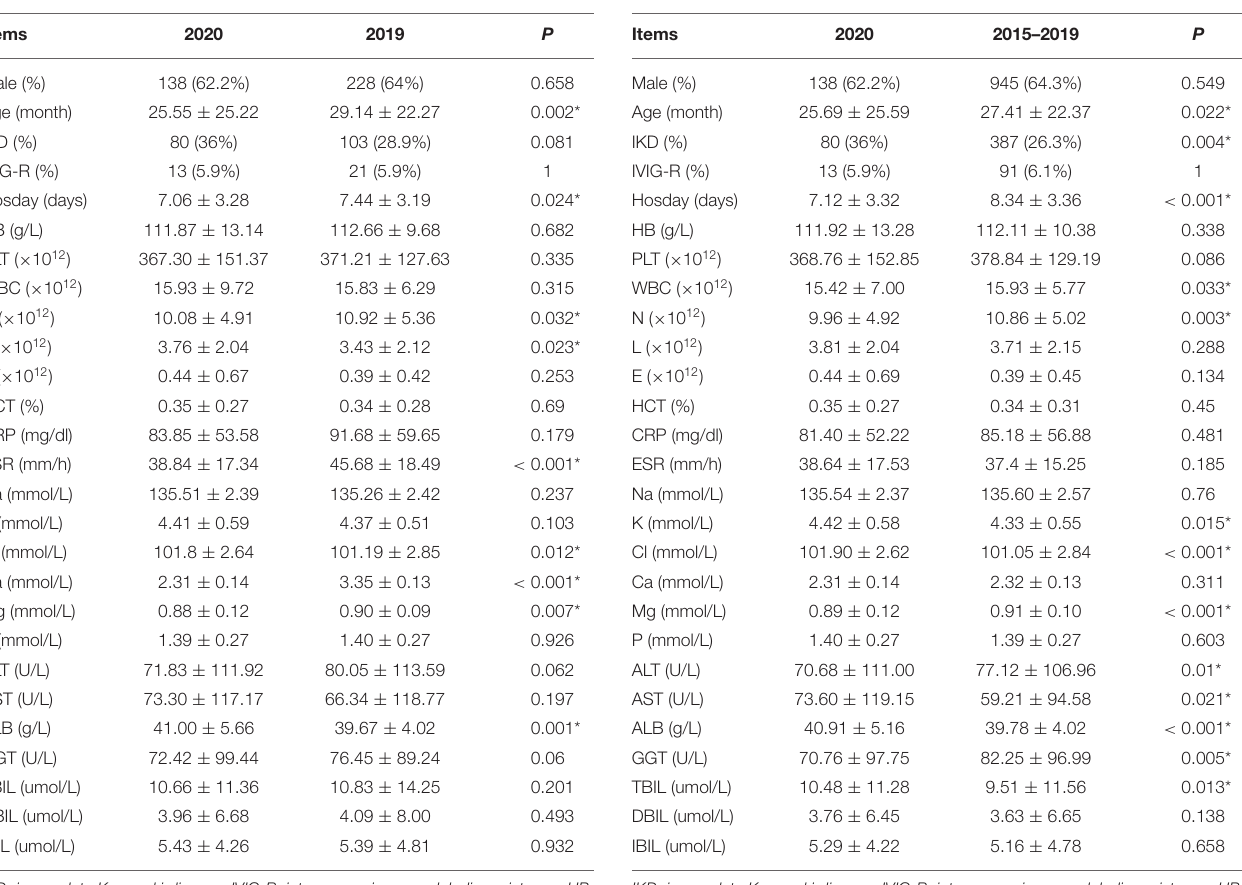
TABLE 1 | Demographic and clinical